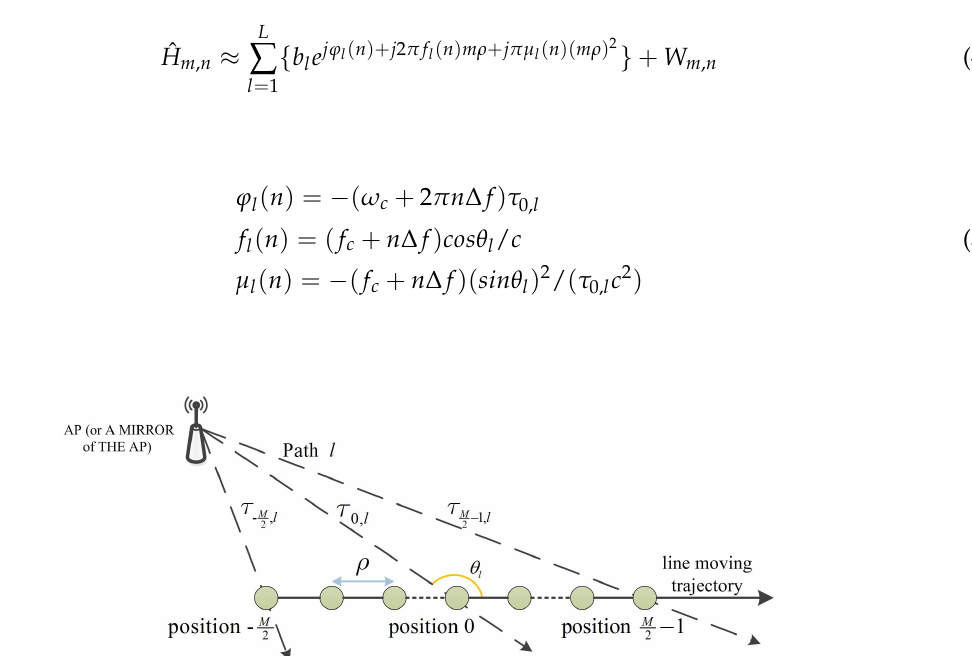
Figure 1. The TOAs of the l -th path at equi-spaced positions on a line moving